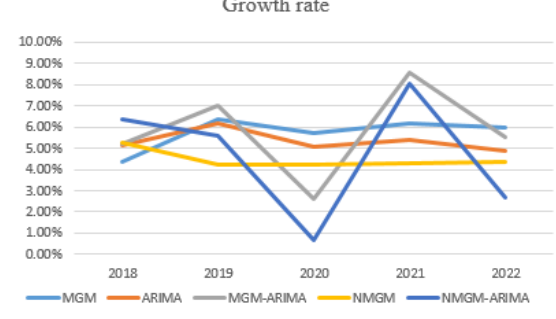
Figure 23. The growth rate of five models, 2018–2022.